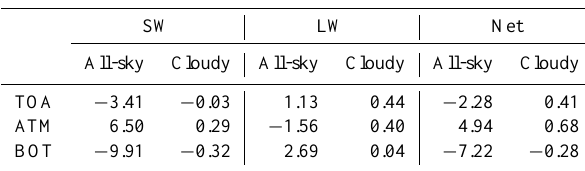
Table 4. Area-averaged direct radiative forcing of dust simulated by WRF-Chem over the entire model domain for JJA 2008 at all-sky and cloudy conditions. Downward radiation is defined as negative. The acronyms have the same meaning as in Fig. 11. Units: Wm − 2